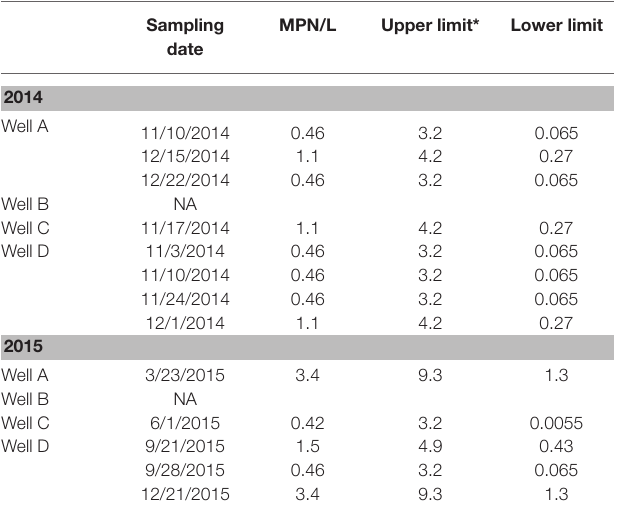
TABLE 1 | Prevalence and most probable number (MPN) values of Salmonella enterica in well water of the four tested farms on the Eastern Shore of Virginia (ESV) in 2014 (sampled 51 weeks in total) and 2015 (49 weeks).